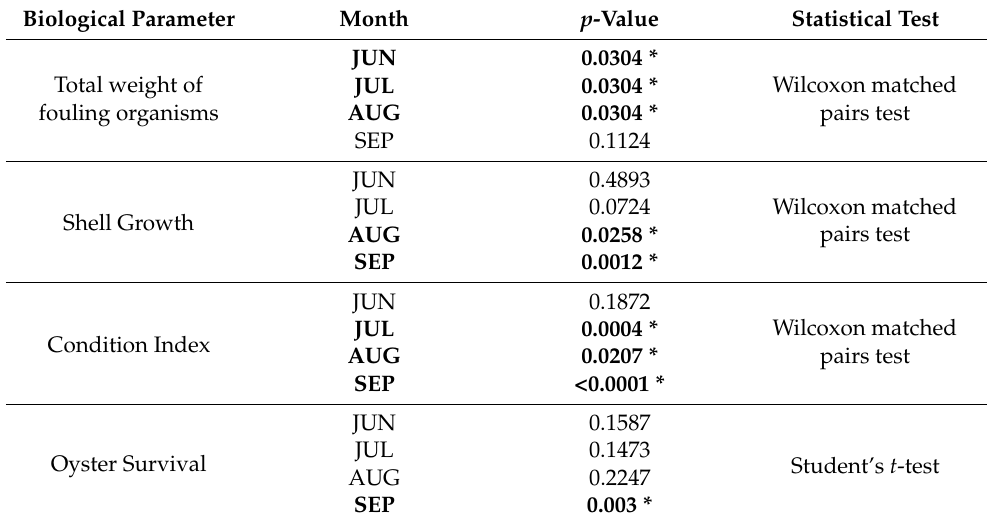
Table 3. Monthly comparison of the total weight of fouling organisms and each biological parameter between the control and A. minuta groups in the field experiment. Treatments with a p -value < 0.05 were considered significant and highlighted in bold and with an asterisk